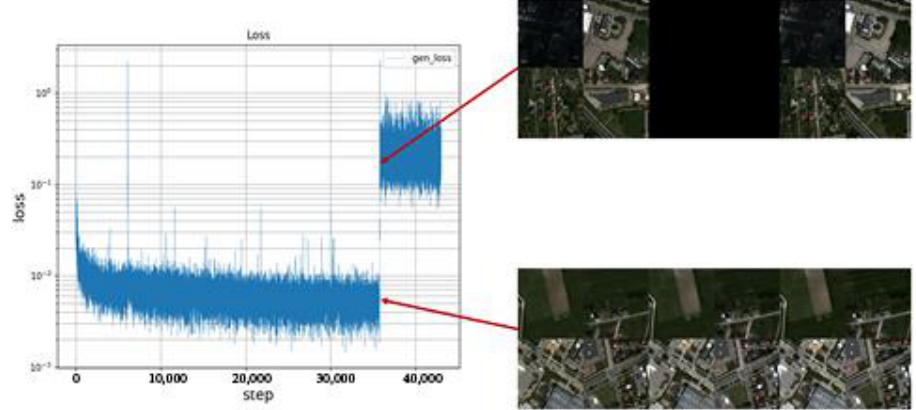
Figure 8. Sample pairs of ( a ) LR and ( b ) HR images that were used to train the ESRGAN network.